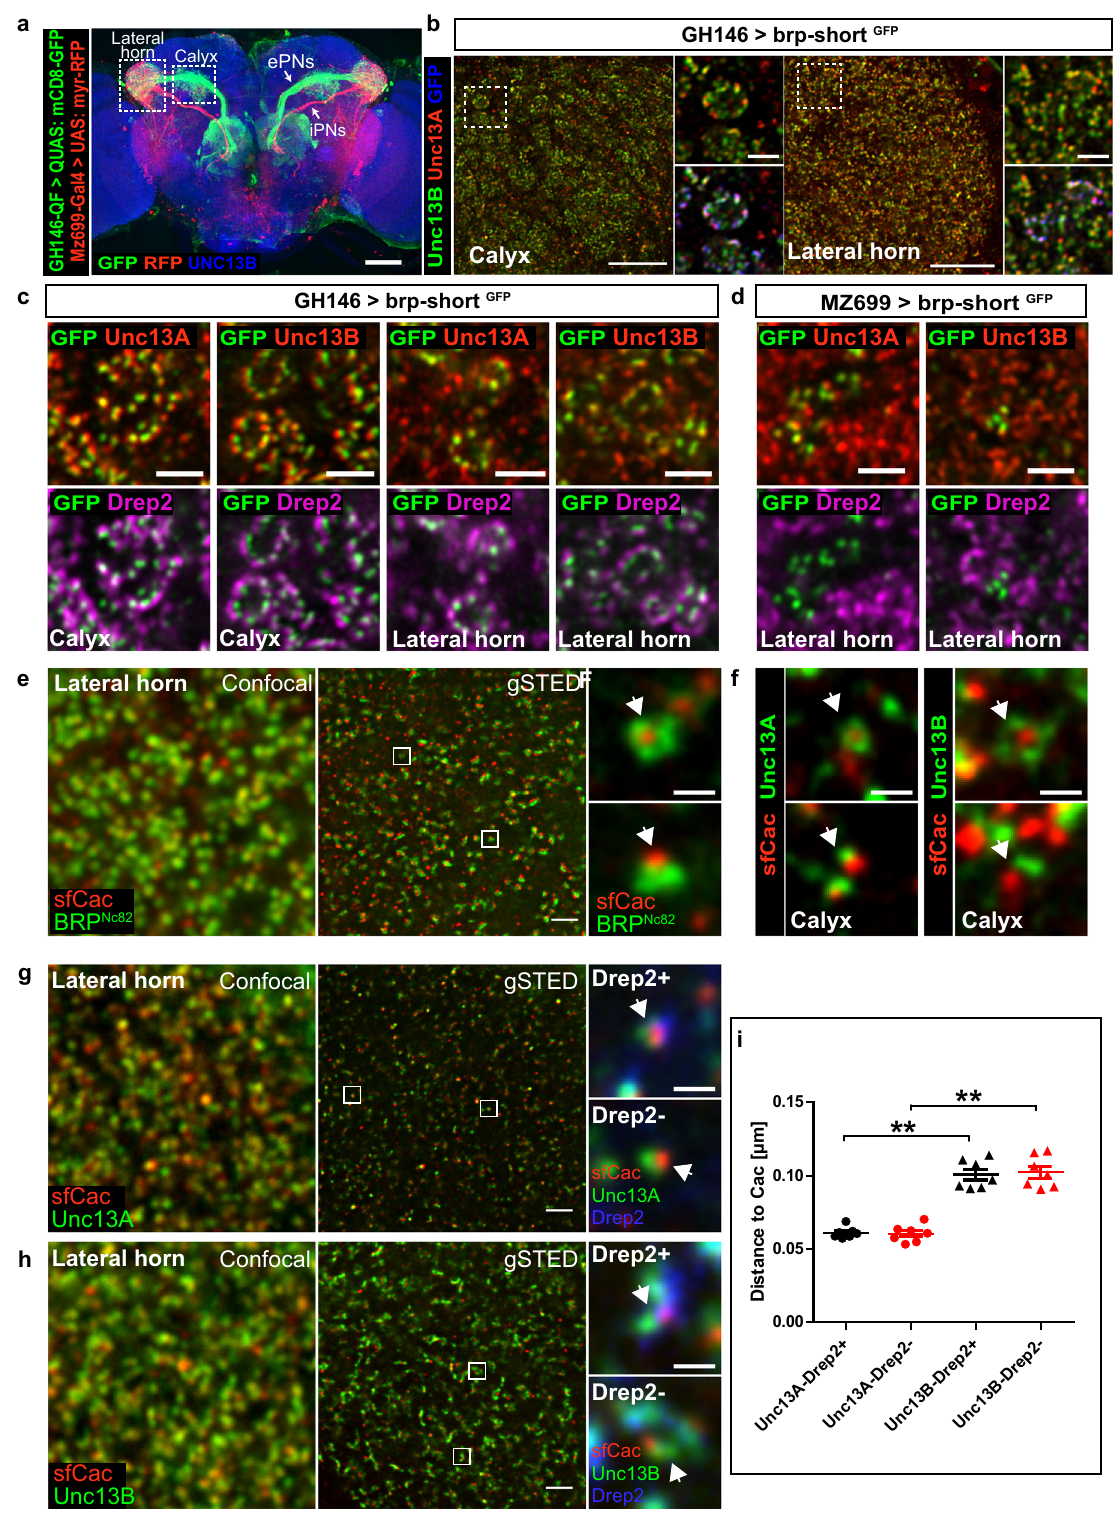
lateral resolution ~40 nm) imaging, using a fl y line in which voltage- operated Ca 2 + channel α 1-subunit Cacophony was functionally on- locus tagged with GFP (sfCac GFP ) 22 . gSTED images of planarly imaged AZs in the LH showed Ca 2 + channel clusters surrounded by rings of scaffold protein Bruchpilot (BRP; NC82 monoclonal anti- body) (Fig. 1e), highly reminiscent of the nano-organization pre- viously observed at PN derived AZs in the calyx or at NMJ AZs 12,20 .